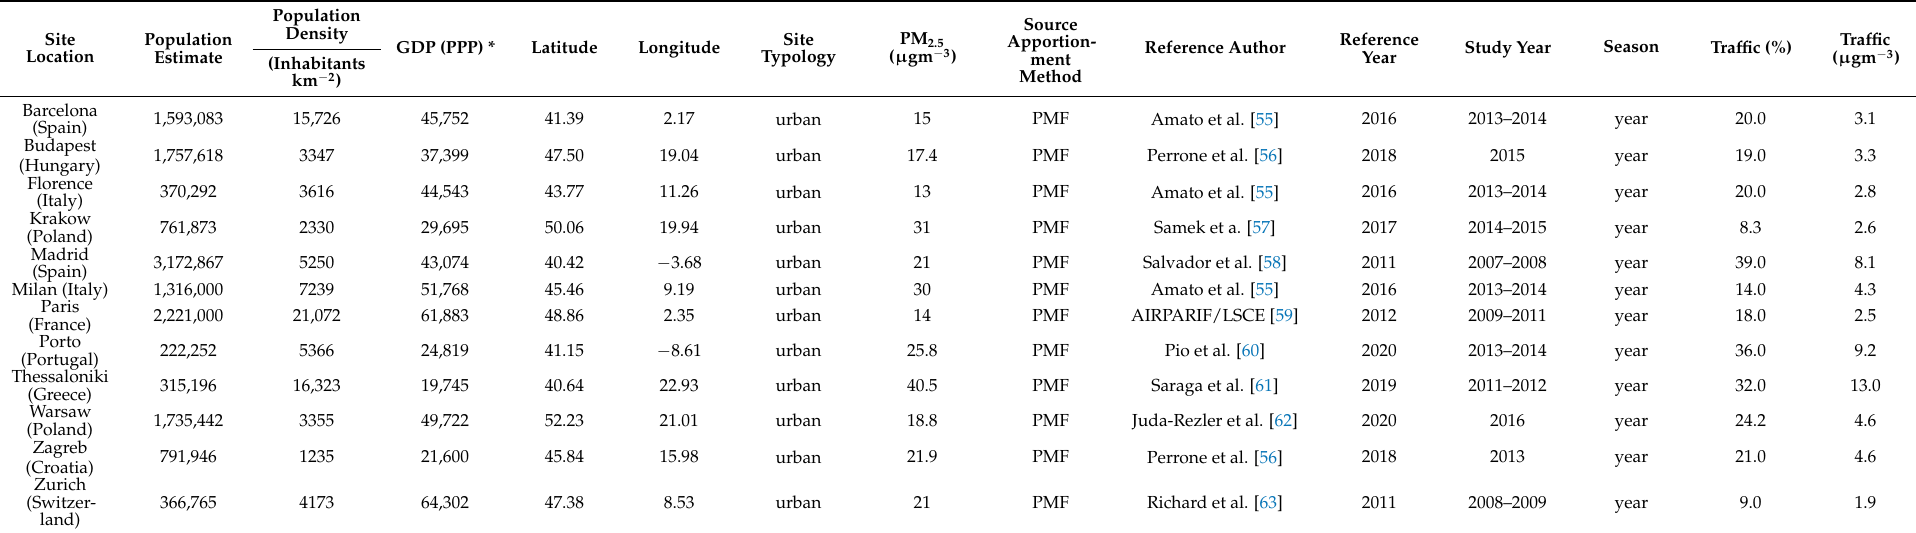
Table 1. Summary of the traffic contributions to PM 2.5 and PM 2.5 concentrations in the cities